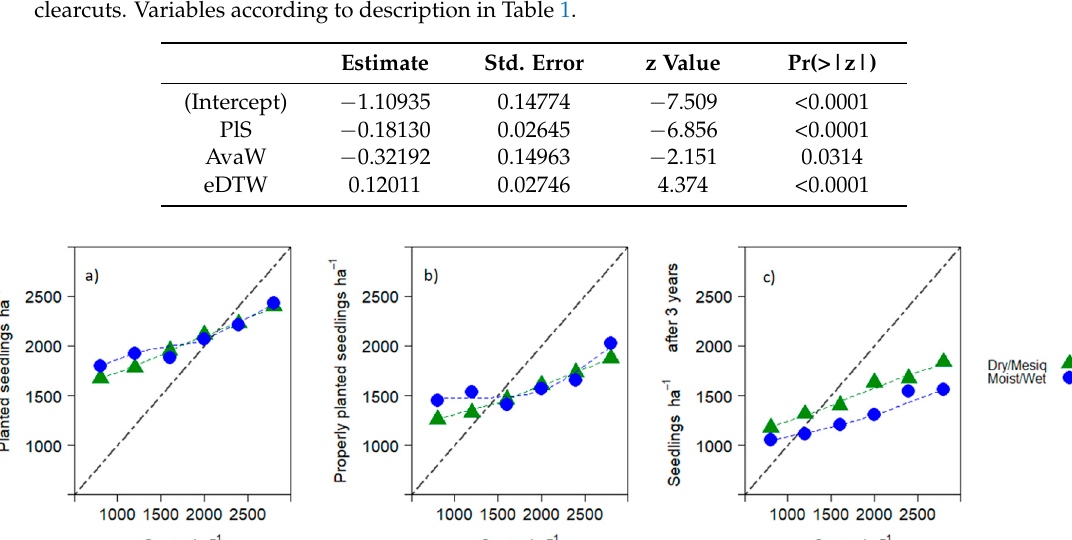
Table 2. Fixed effects reduced model (Equation (2)), with mortality in sample plots nested within clearcuts. Variables according to description in Table 1.